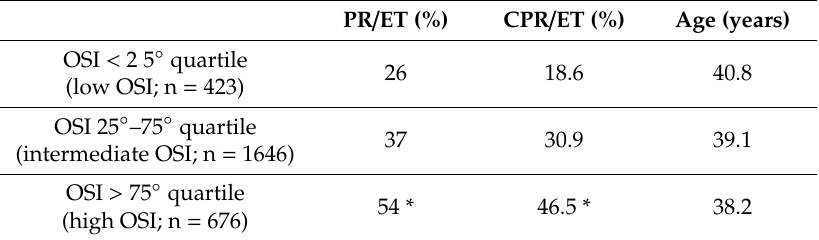
Table 4. Multivariable analysis of the variables associated with clinical pregnancy (CPR/ET). The results are presented with an odds ratio (OR) and 95% confidence interval (95% CI) estimates. OR